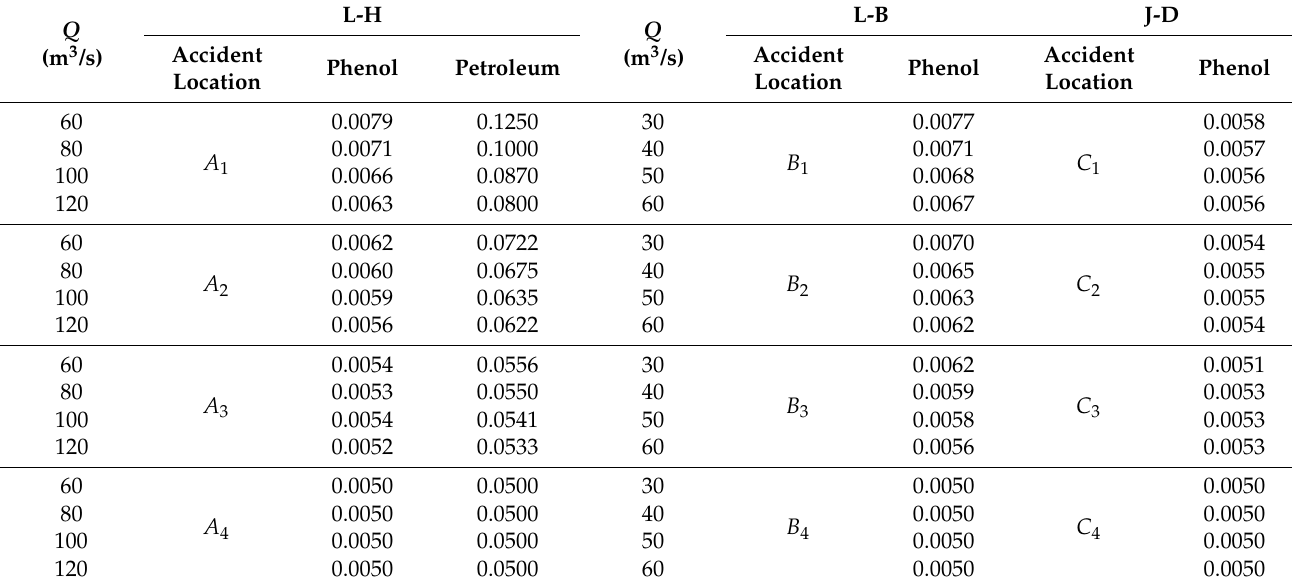
Table 4. Changing process of the pollutant concentration (unit: mg/L).